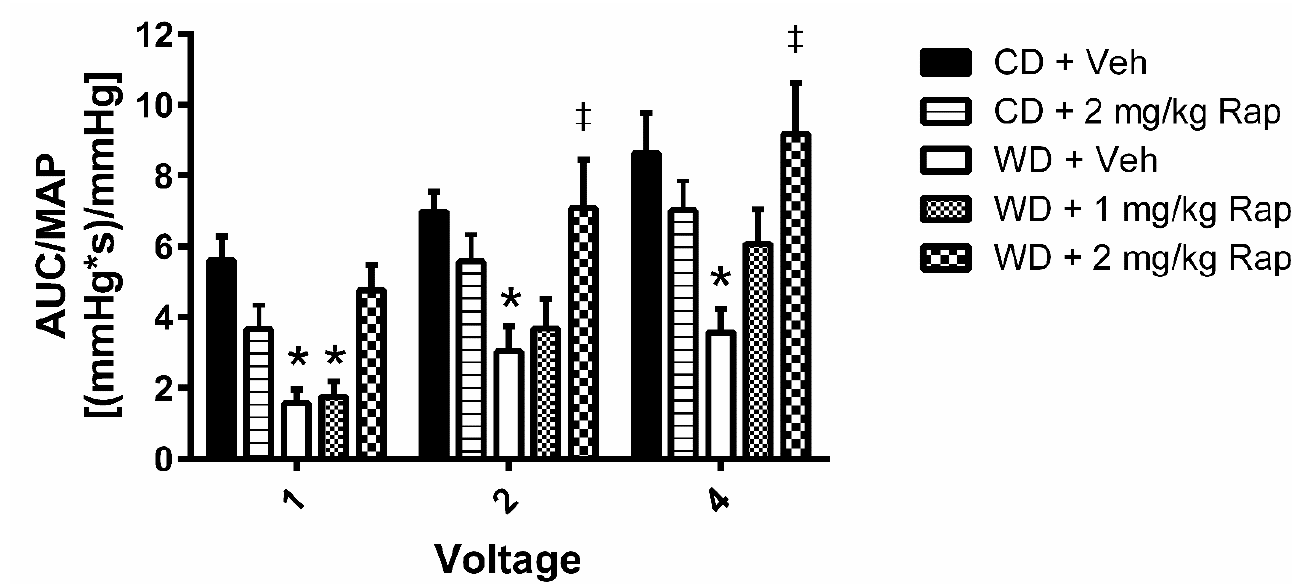
Figure 1. Assessment of cavernous-nerve-stimulated erectile function. Mice were fed the control (CD) or Western (WD) diet and treated with vehicle, 1 mg/kg rapamycin (Rap), or 2 mg/kg Rap. The cavernous nerve was stimulated at increasing voltages (1, 2, and 4 V) for one minute at each voltage. Erectile function is assessed by the area-under-the-curve (AUC) of the intracavernous pressure response to electrical stimulation normalized to mean arterial pressure (MAP). Data are presented as mean ± standard error of the mean for n = 7–10 mice per group; * p < 0.05 vs. CD + Veh, ‡ p < 0.05 vs. WD + Veh.